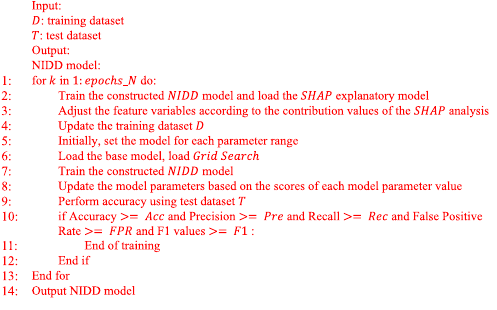
The core algorithmic process of the NIDD model con- sists of two main parts.